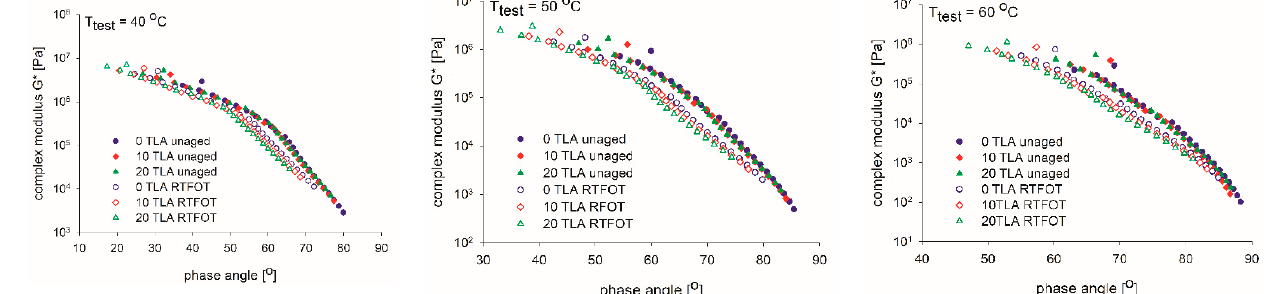
Materials 2021 , 14 , x FOR PEER REVIEW 12 of 19